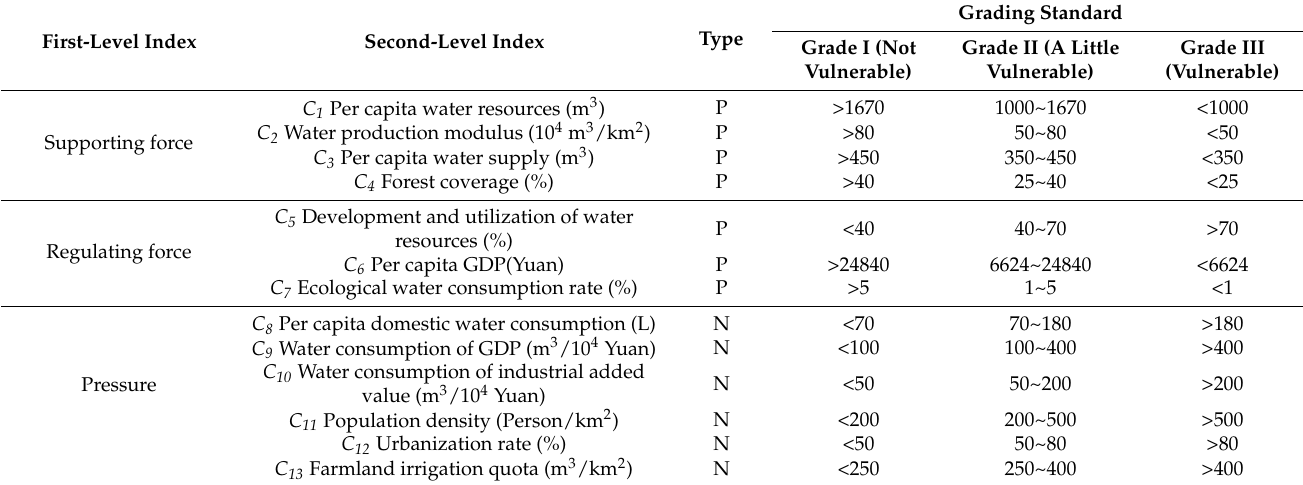
Table 1. Index system and grade classification standard of the vulnerability of